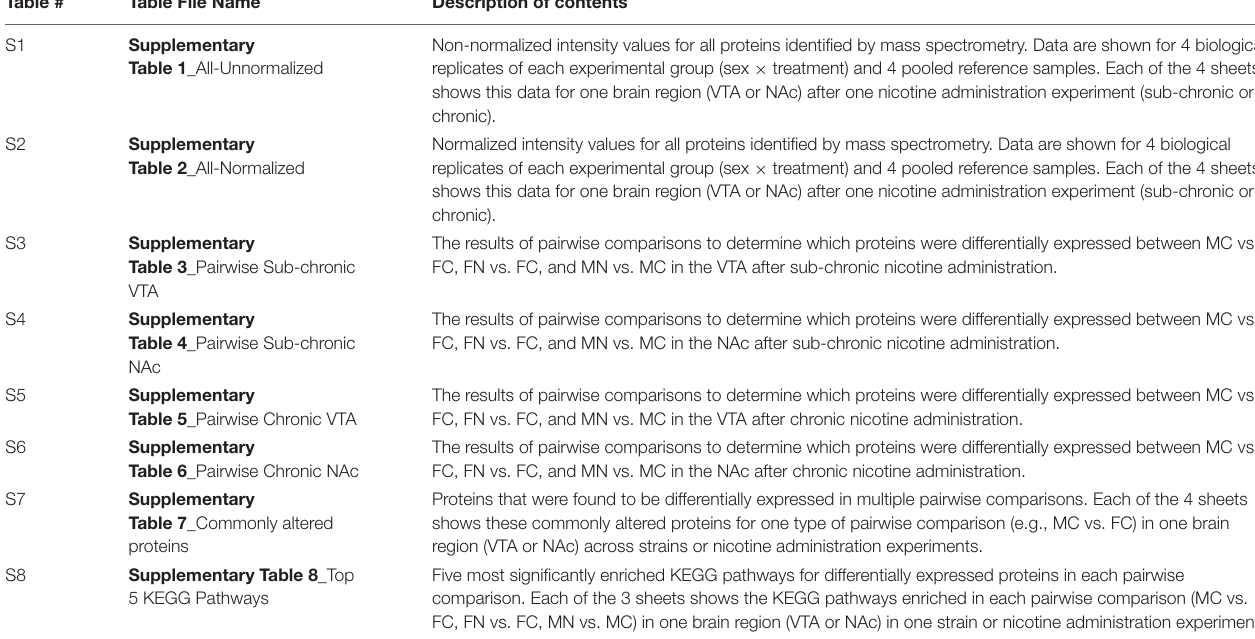
TABLE 1 | Summary of data provided in Supplementary Tables 1–8